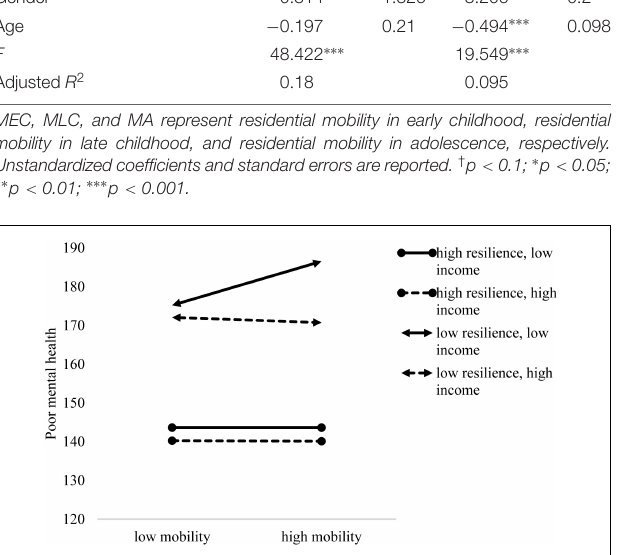
p = 0.293, 95%CI: [ − 0.241, 0.073]; the 3-way interaction